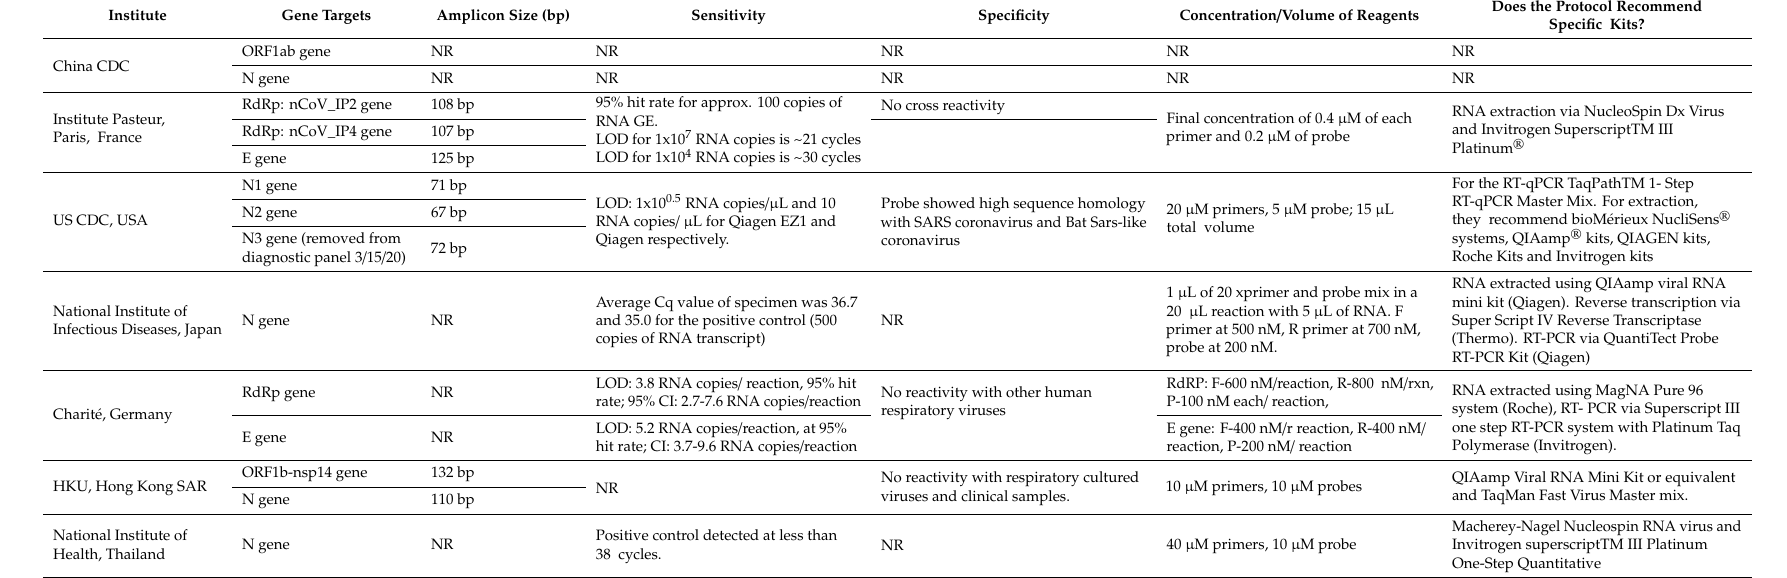
Table 2. Summary table of available protocols posted to the WHO’s